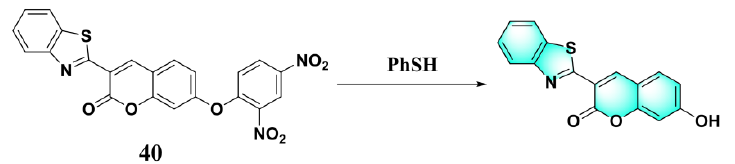
Figure 16. Structure and reaction of probe 40 with PhSH.